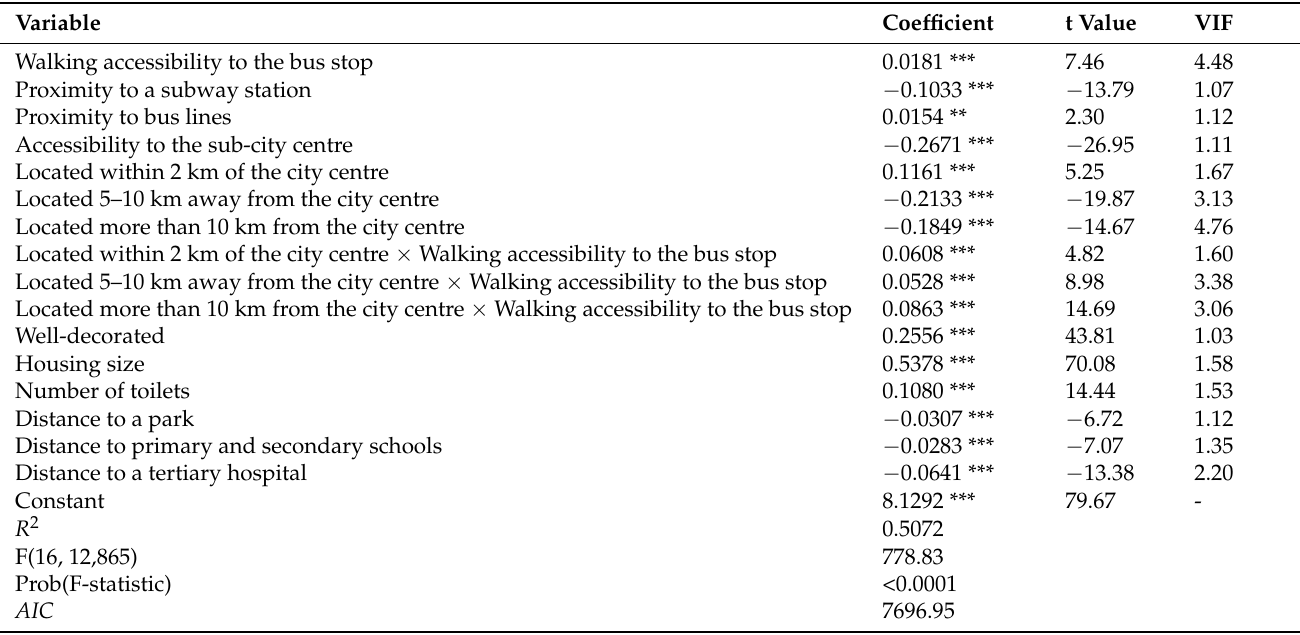
Table 4. OLS regression results of residential location heterogeneity.